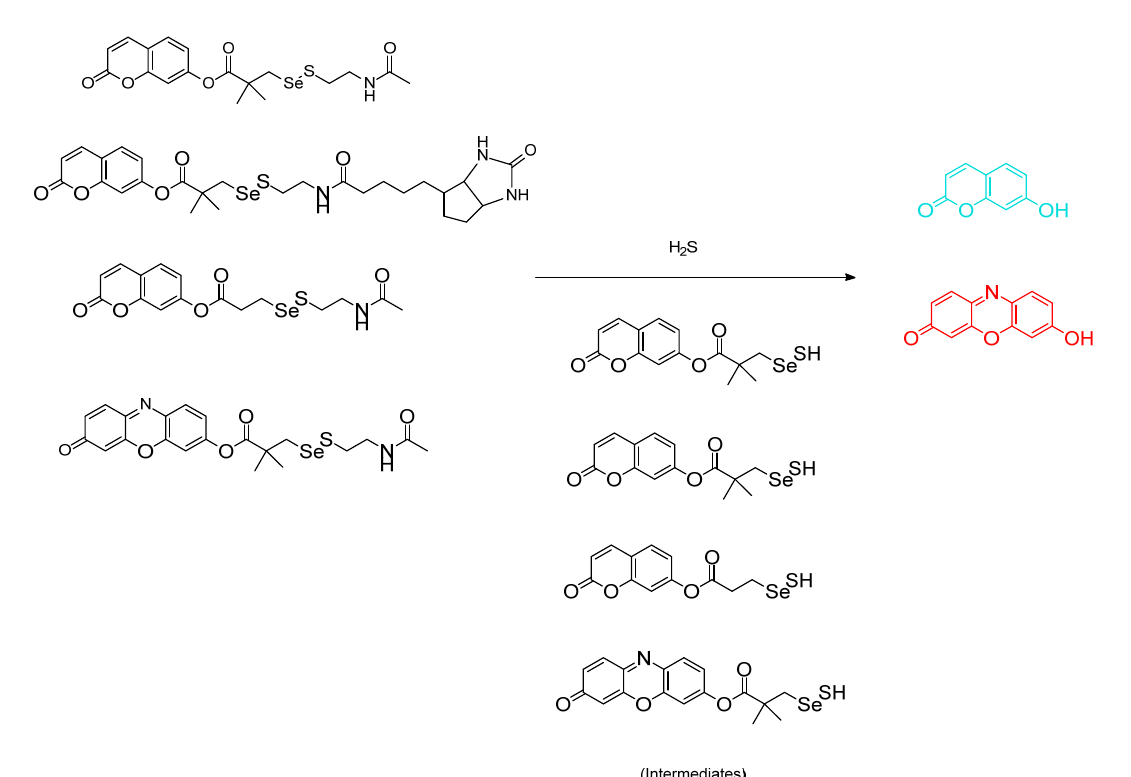
Figure 23. Structures from the report by Suarez et al. describe Selenosulfide gem–Dimethyl Ester conjugation for the goal of improving future H 2 S chemosensing.